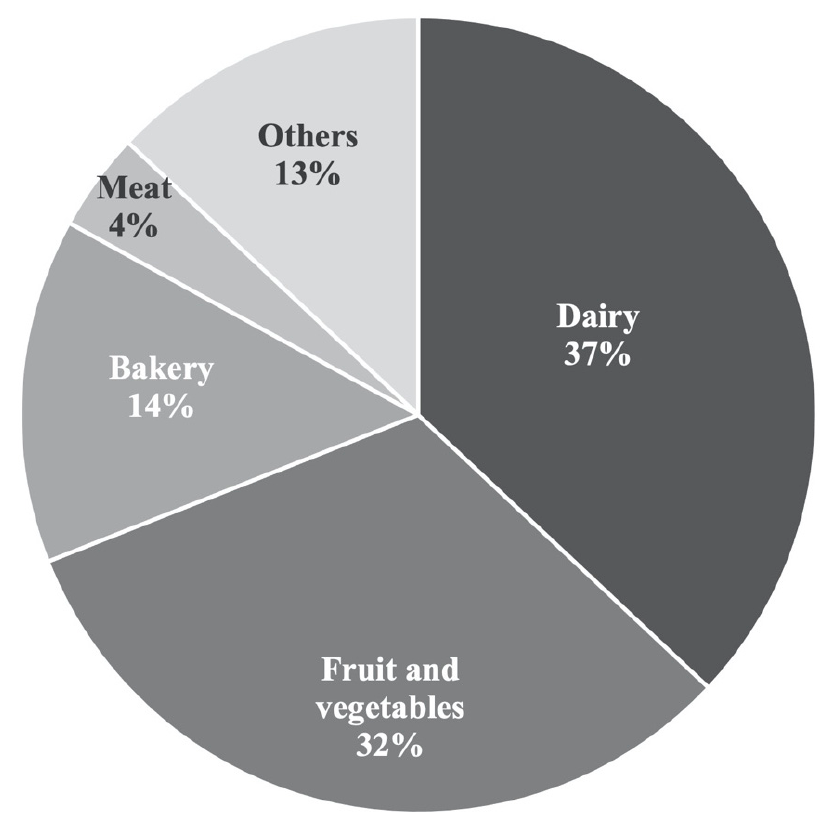
Figure 1. Percentage distribution in the literature of papers dealing with probiotic microcapsules application in different food categories in the period 2015 to date.